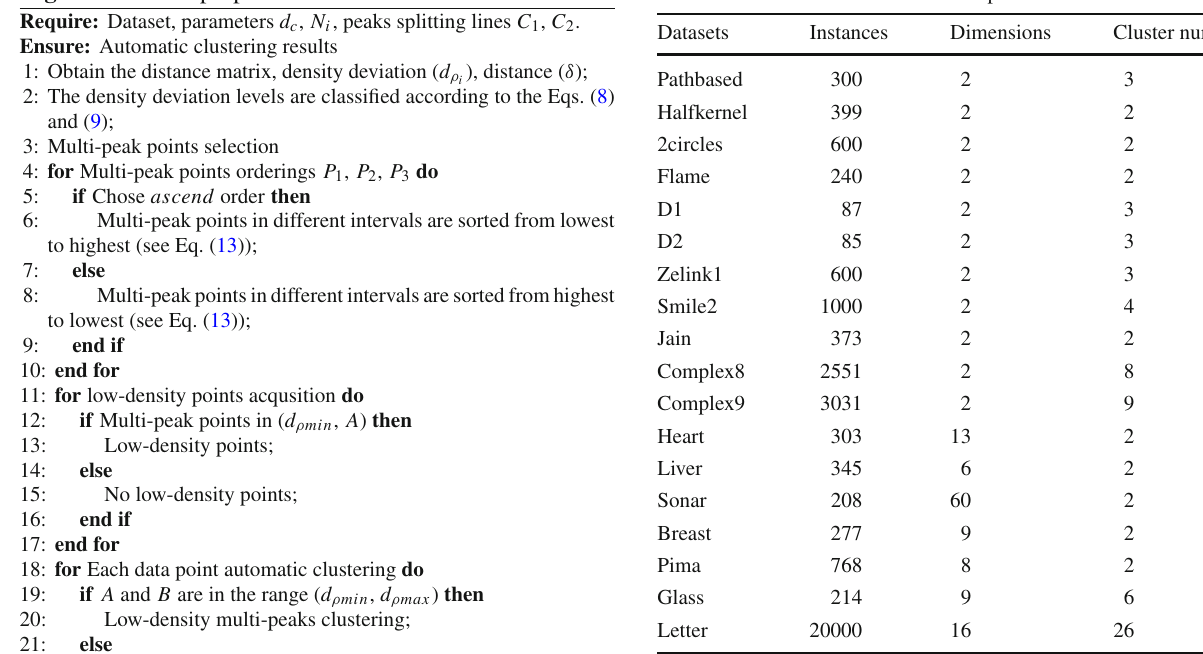
Algorithm 1 The proposed AmDPC method Table 1 Datasets characteristics